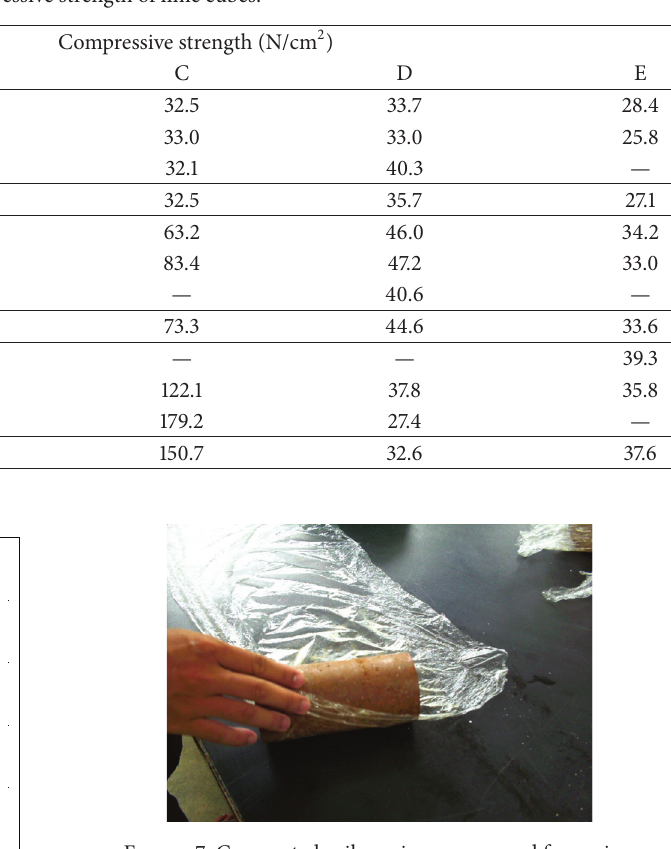
Table 4: Compressive strength of lime cubes.